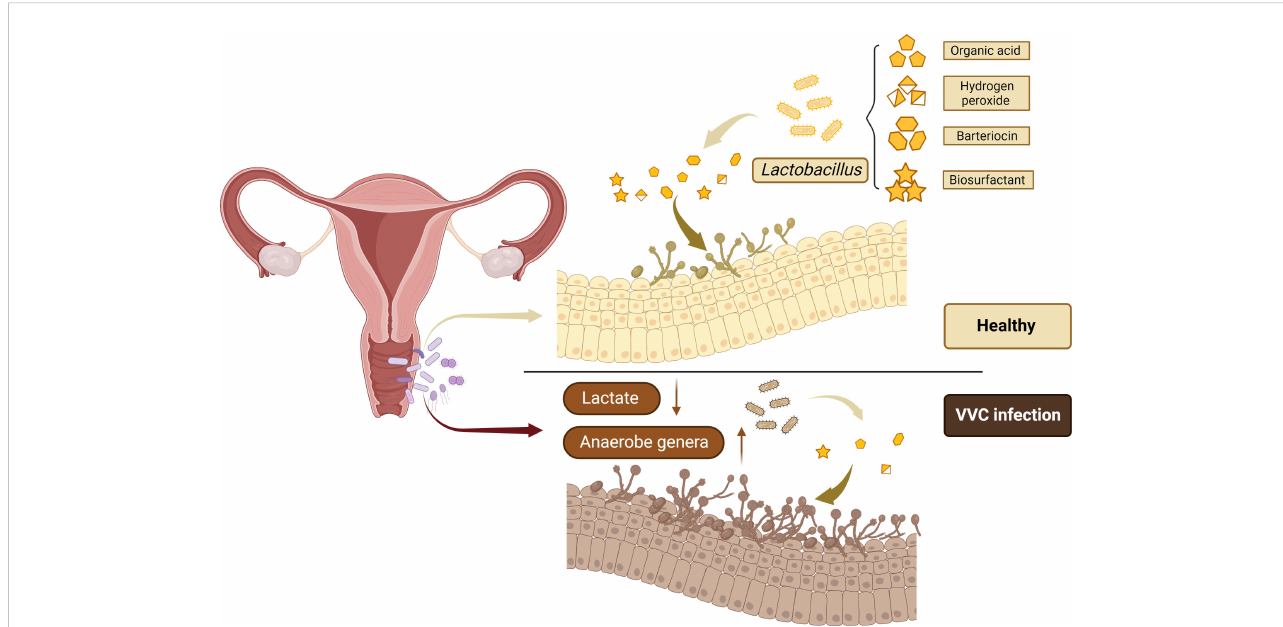
FIGURE 1 Lactobacillus is the most frequently isolated microorganism from the healthy women vagina to prevent the colonization and overgrowth of pathogens by excreting metabolic by-products, including organic acid, hydrogen peroxide, bacteriocin, and